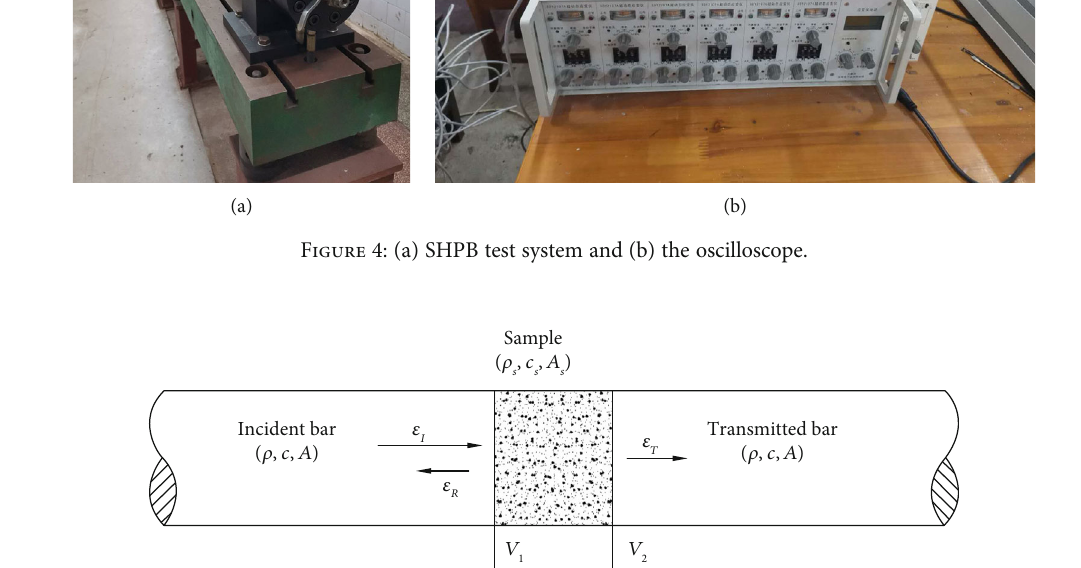
Figure 5: Symbols describing the parameters for the incident and transmitted bars and the specimen interface velocities